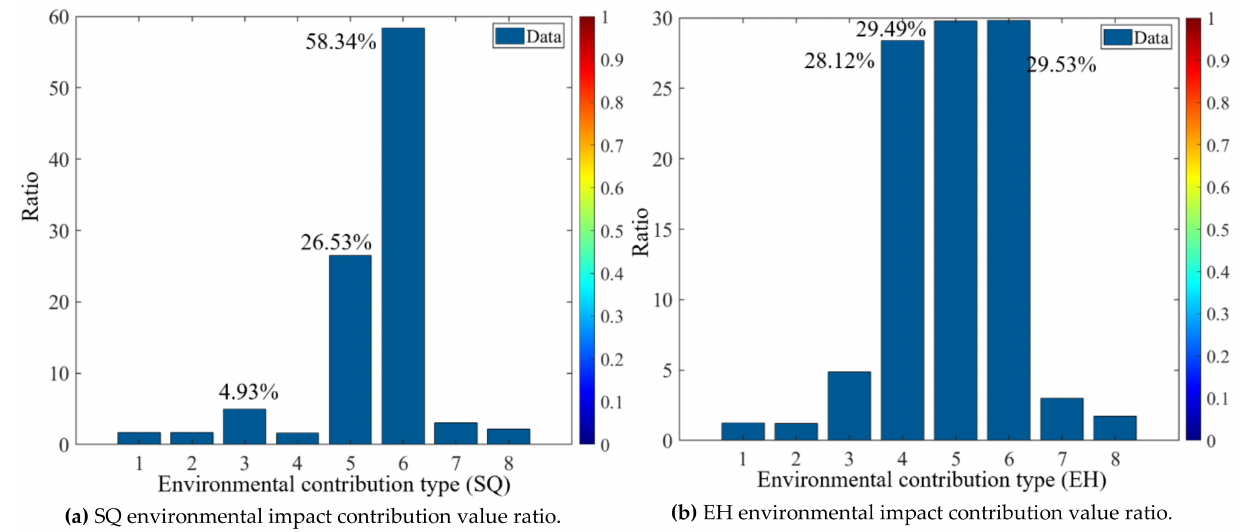
Figure 15. A schematic diagram of the numerical comparison of the environmental impact contribution types of SQ and